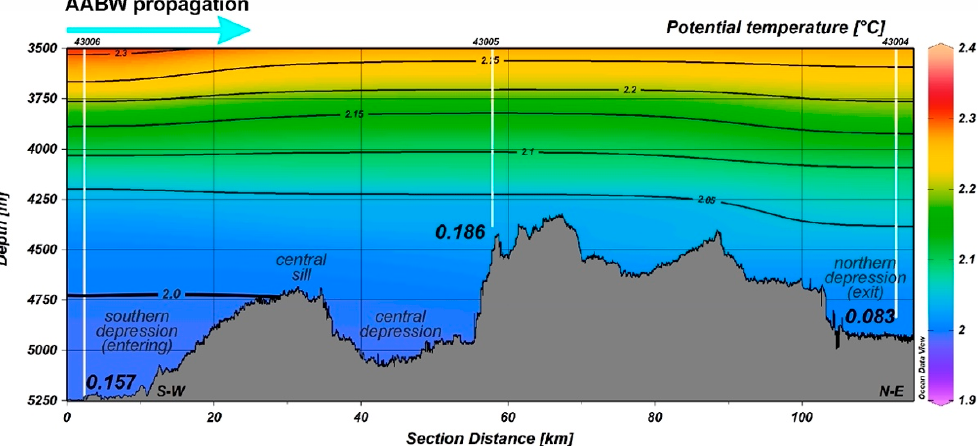
Figure 5. Potential water temperature profile through Discovery Gap. The near-bottom suspended particulate matter concentrations (mL/L) are shown by black italic type. AABW—Antarctic Bottom Water. Numerals at the top indicate locations and numbers of stations. The position of the section is shown in Figure 2a.